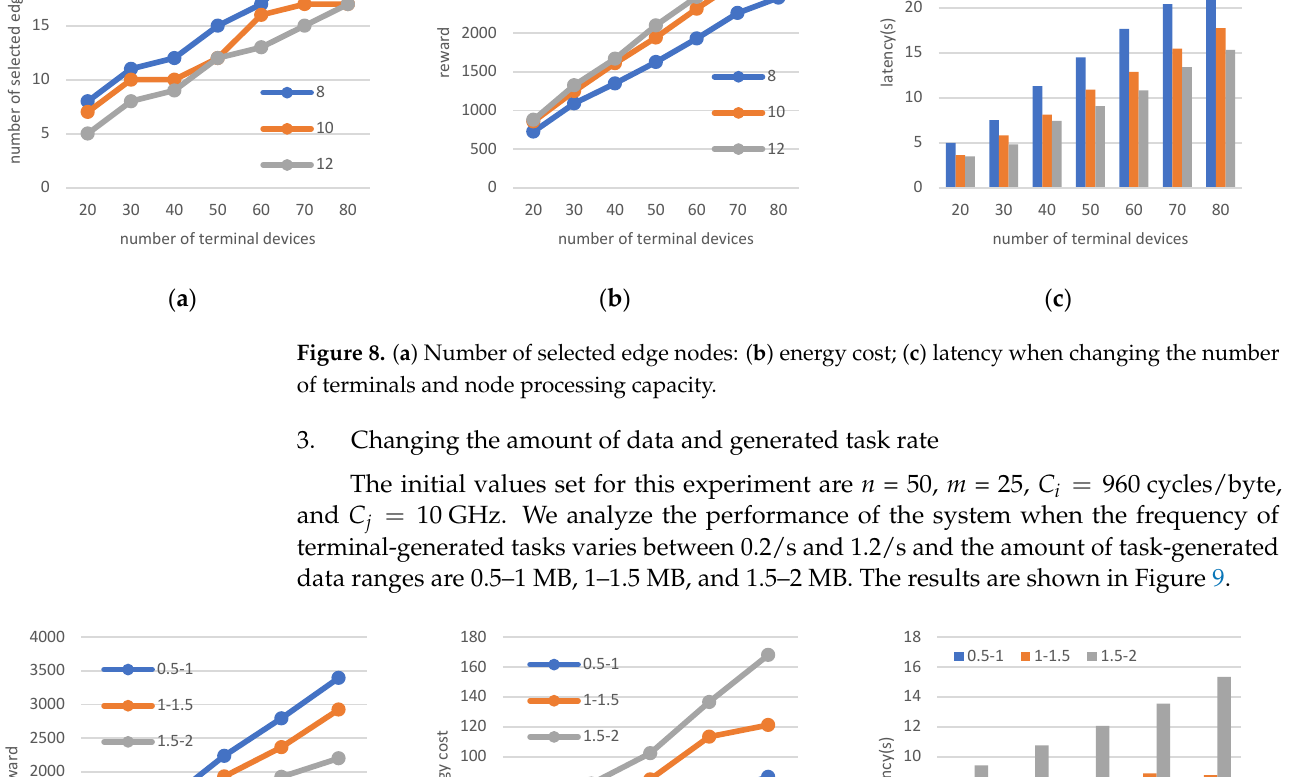
significantly reduce the latency, as shown in Figure 8c. When the node capability is increased from 8 GHz to 10 GHz with 80 terminals, the latency time decreases by 28.0% and by 13.6% when the processing capability is increased from 10 GHz to 12 GHz.